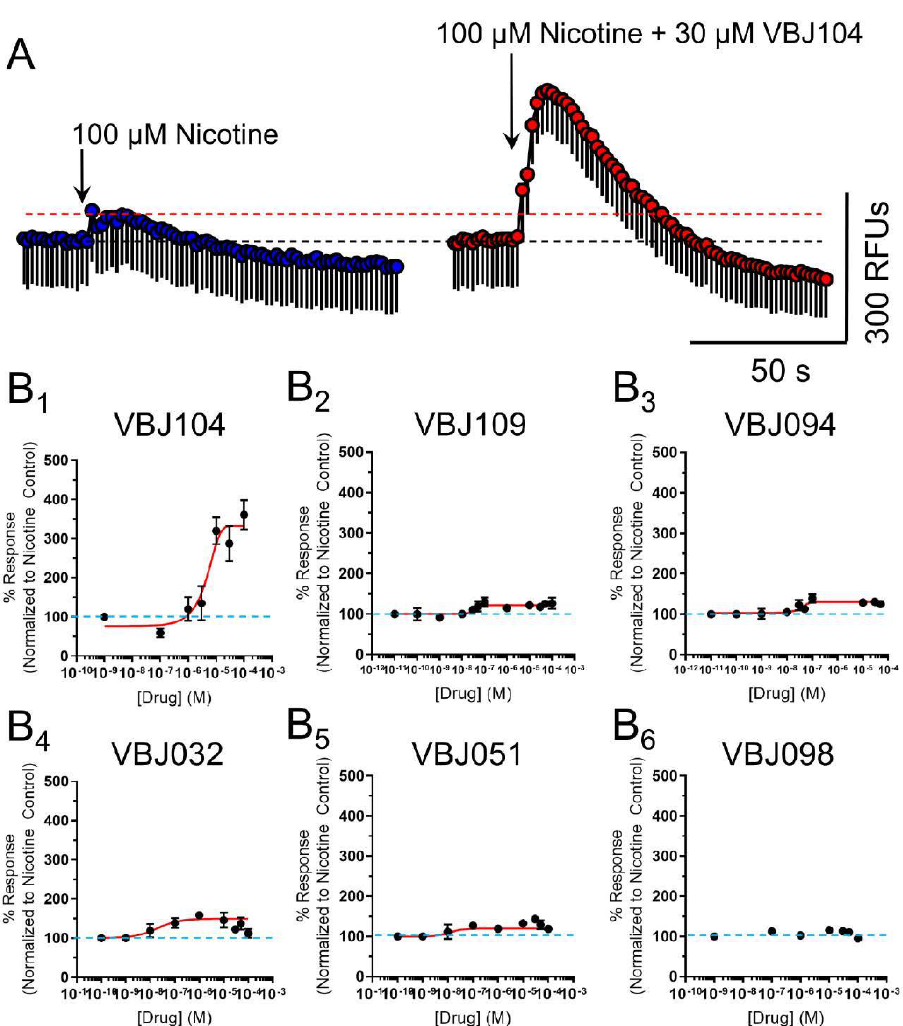
Figure 4. ( A ) Representative Ca 2+ flux from a 100 µM application of nicotine (left) and a 2 µM application of nicotine in the presence of 30 µM VBJ104 on cells transiently transfected with mouse α4β2 nAChRs. Data are mean ± SEM (triplicate data points). ( B 1 – B 6 ) Concentration – response curves for varying concentrations of VBJ ligands in the presence of 100 µM nicotine. For B 1 – B 6 , n = 4 – 7 individual experiments.